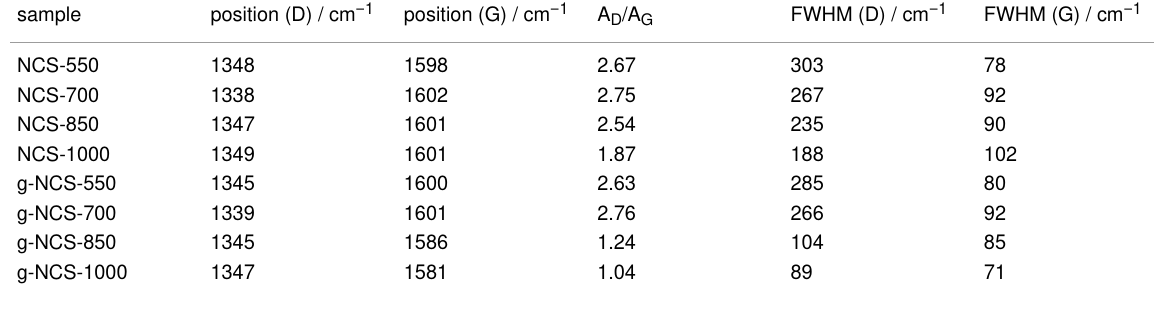
bands at, e.g., ca. 860 cm − 1 and ca. 2440 cm − 1 is described in detail by Kawashima and Dresselhaus and co-workers